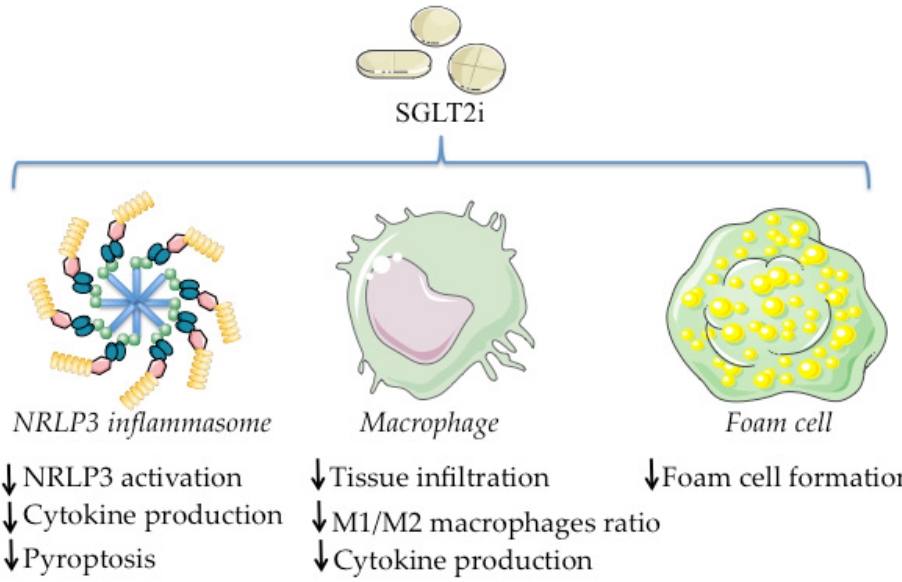
Figure 3. Main anti-inflammatory effects of SGLT2i. The figure was drawn using pictures from Ser- vier Medical Art, which are licensed under a Creative Commons Attribution 3.0 Unported License (http://smart.servier.com/, 21 April